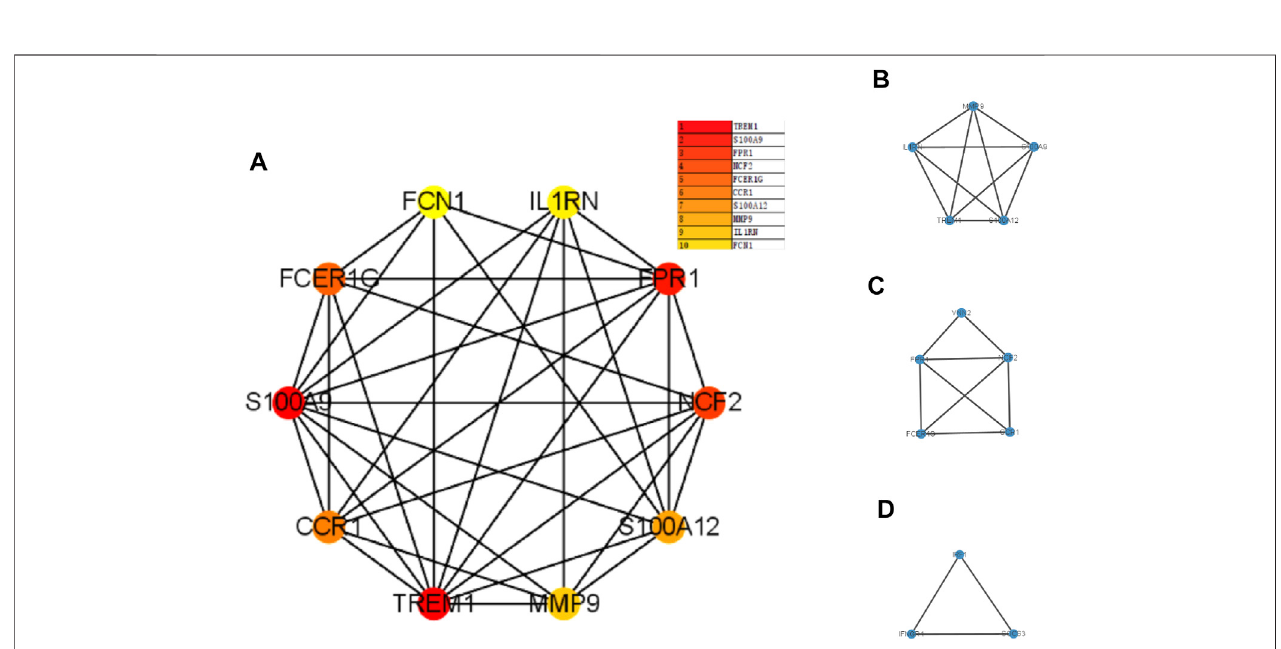
FIGURE5| The PPInetwork analyzed by cytoHubba and MCODE. Panel (A) ,PPInetworkforthe top 10hubgenes.Panel (B – D) , threeclustermodulesextracted by MCODE. Abbreviations: PPI, protein-protein interaction; MCODE, Minimal Common Oncology Data Elements.